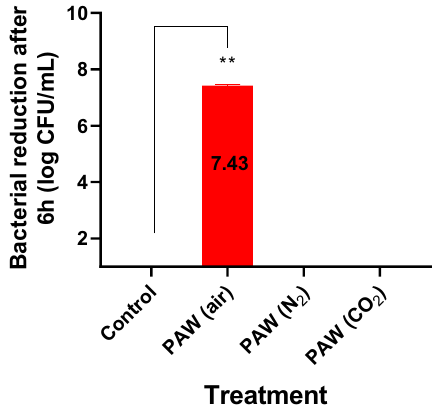
Figure 4. Total reduction of E. coli (log CFU/mL) within 6 h of exposure to different PAWs. **P ≤ 0.01.